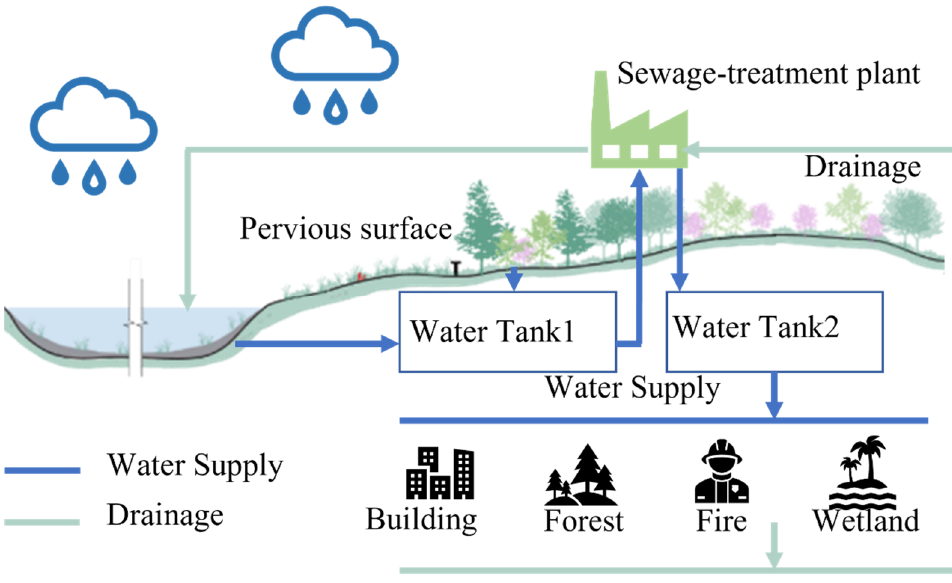
Figure 15. Function of rainwater storage facilities.